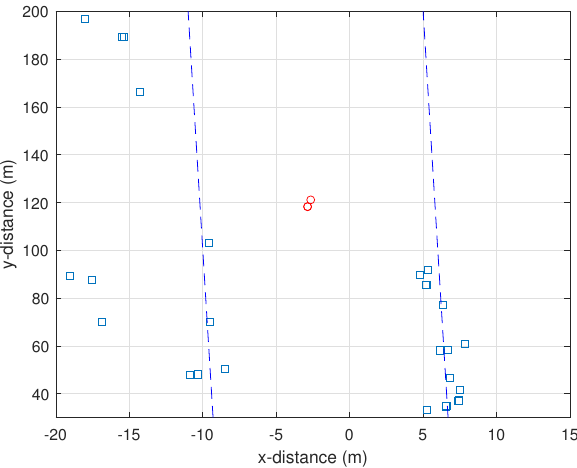
Figure 11. Reclassification result for detected